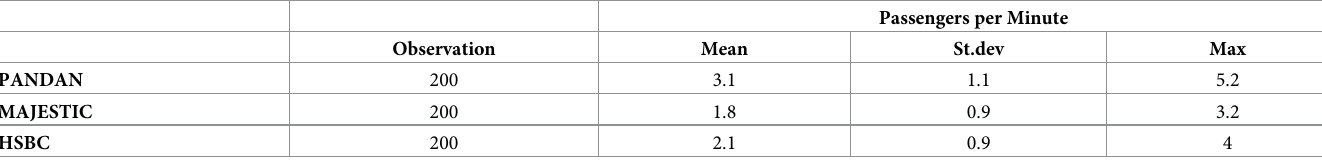
Table 7. Passenger arrival rate per minute for Route U32, AM peak, inbound.